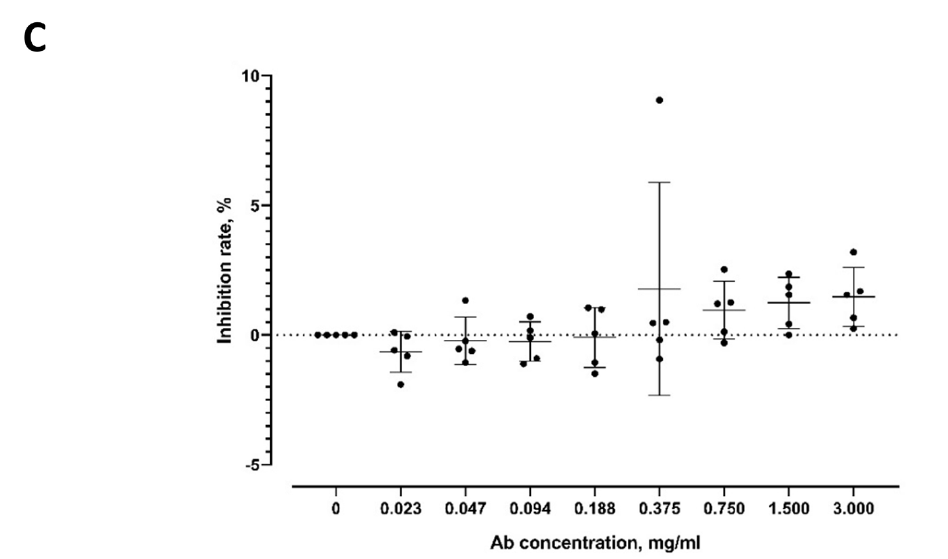
Figure 2. Merozoite invasion inhibition rate of gradient concentration of anti-PkAMA-1 by microscopy examination. This assay was performed in 5 biological replicates; error bars represent the means and standard deviation. ( A ) Via Kruskal-Wallis with Dunn’s post-test, significant merozoite invasion inhibition by anti-PkAMA-1-DII-P was found at 0.375 mg/mL ( p = 0.0225), 0.75 mg/mL ( p = 0.0035), 1.5 mg/mL ( p = 0.0003), and 3 mg/mL ( p < 0.0001). No significant merozoite invasion in-